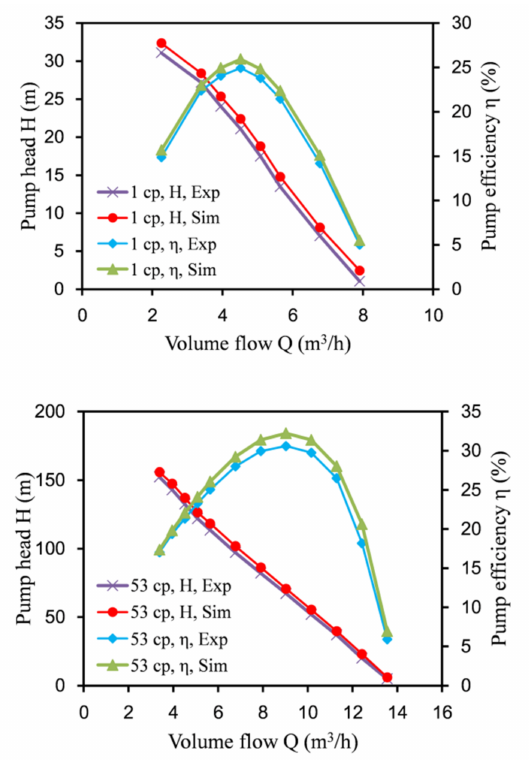
Figure 5. Comparison of test and simulation